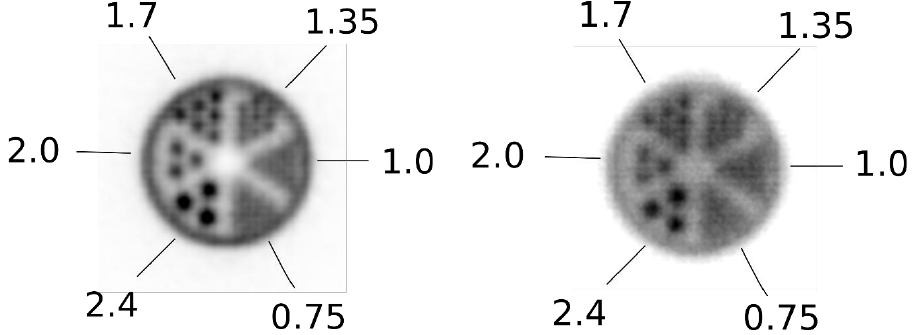
Figure 7. Images of the micro hotspot phantom reconstructed using an MLEM reconstruction ( left ) and with a back-projection reconstruction ( right